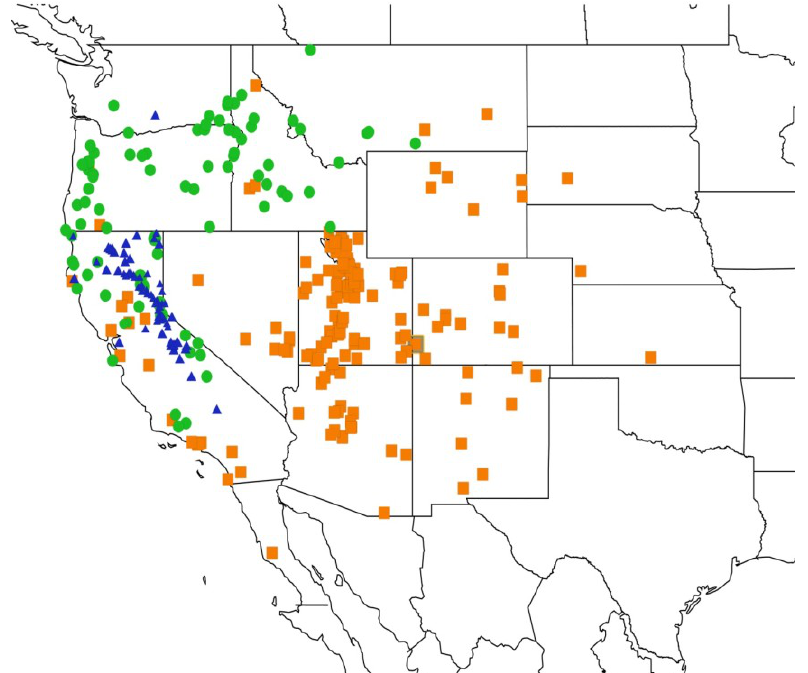
Figure 53. Distribution of Okanagana oregona (green circles), O. nigrodorsata (blue triangles) and O. striatipes (orange squares).